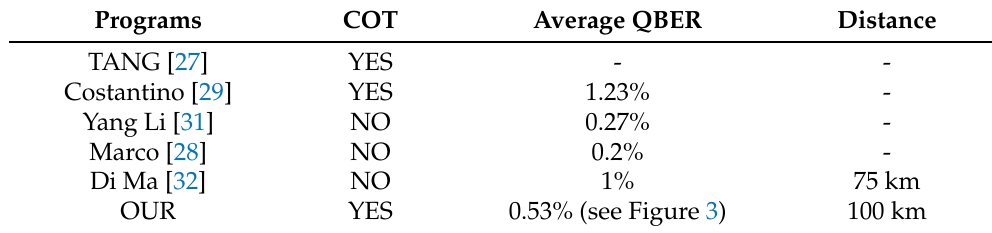
Table 1. Comparison of polarization coding